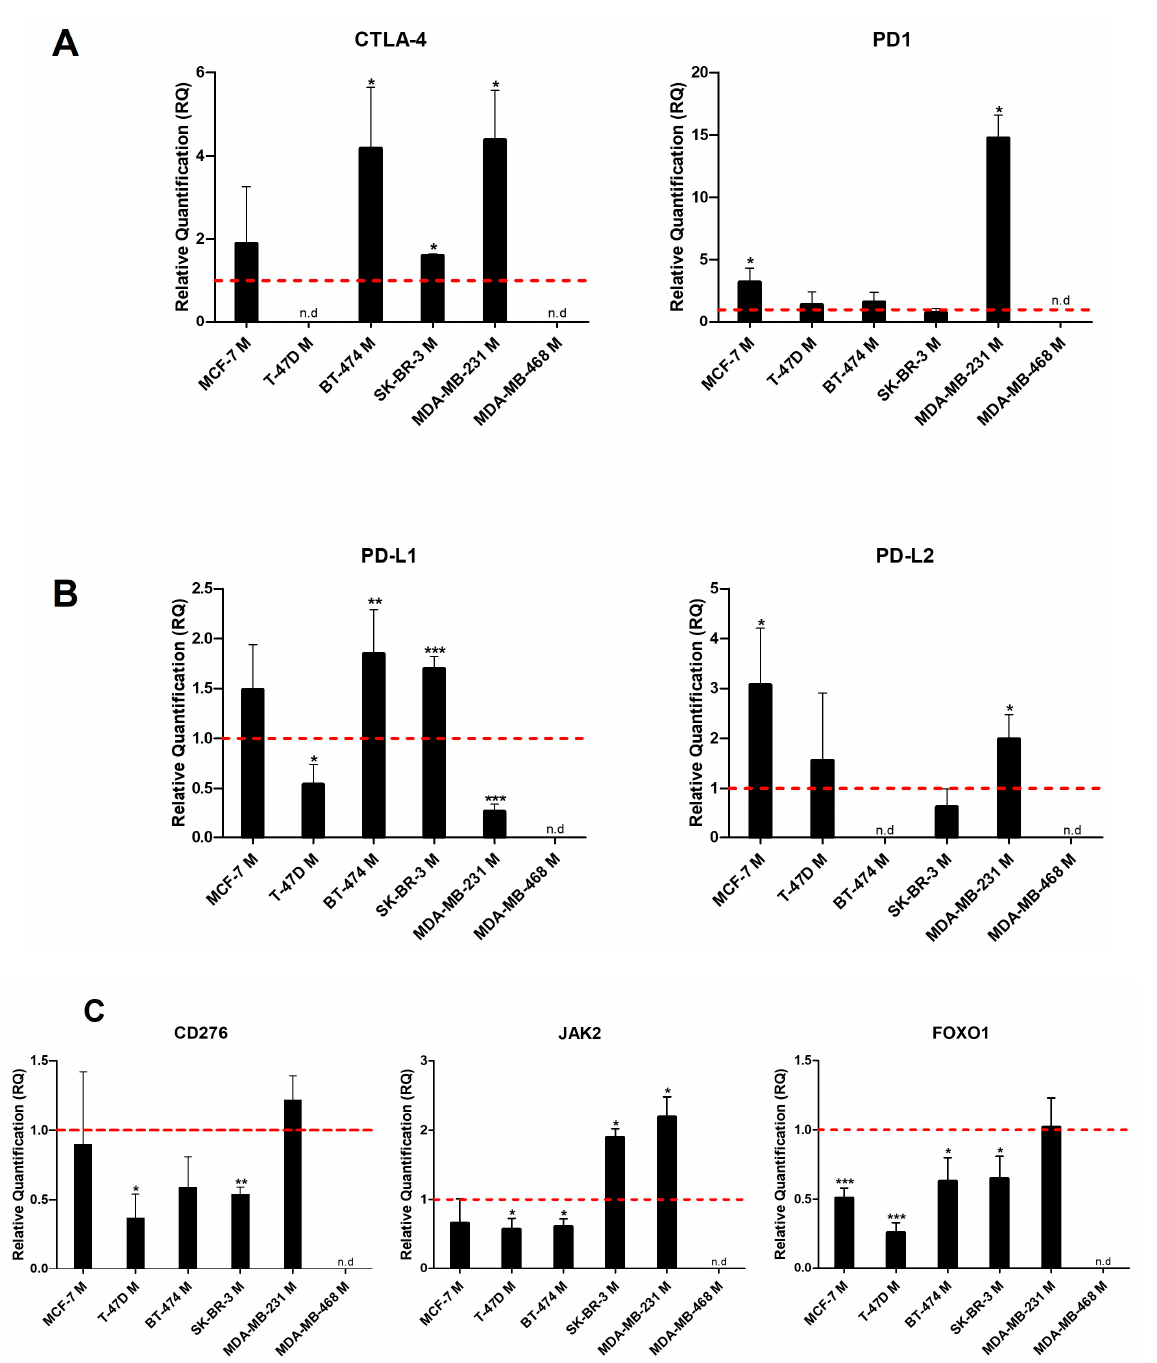
Figure 2. Relative mRNA quantification of ( A ) CTLA-4 , PDCD1 (PD1), ( B ) CD274 (PD-L1), PDCD1LG2 (PD-L2), ( C ) CD276 (B7-H3), JAK2 , and FoXO1 genes in mammospheres (M) derived from breast cancer cell lines. All experiments were performed in triplicate. Each graph shows the three replicates’ mean value and standard deviation. * p < 0.05; ** p < 0.01; *** p < 0.001 compared to the corresponding BC cell line (red line). n.d., no